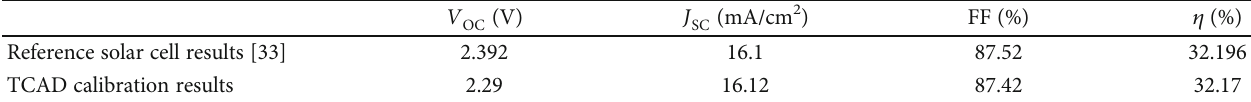
Table 3: TCAD simulation results for the calibrated cell in comparison with